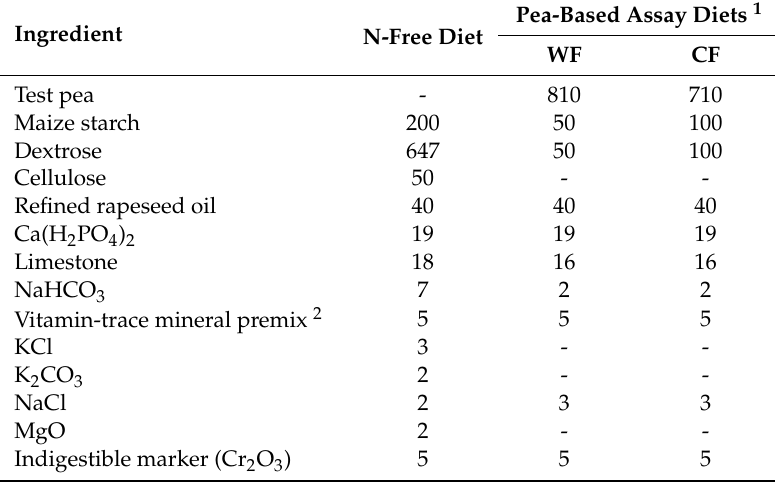
Table 1. Composition (g / kg as fed) of nitrogen-free diet used to estimate basal ileal endogenous amino acid losses and the assay diets for the determination of apparent ileal amino acid digestibility of the pea